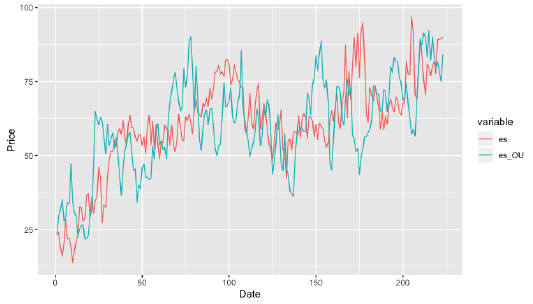
Figure 9. Simulation Result of OU model on energy-switching